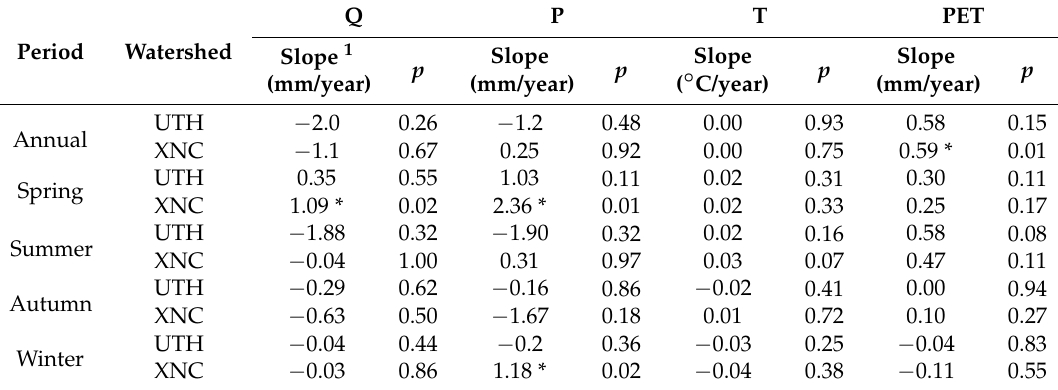
Table 2. Results of Mann-Kendall trend tests on hydrometeorological variables in the UTH watershed and XNC watershed from 1987 to 2016.